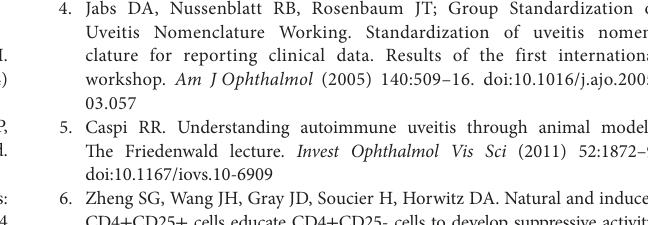
TaBle s3 | Unique Fluidigm barcodes added to the PCR products in the Fluidigm assay for DNA methylation analysis. TaBle s4 | TIGIT + Treg as a biomarker of clinical